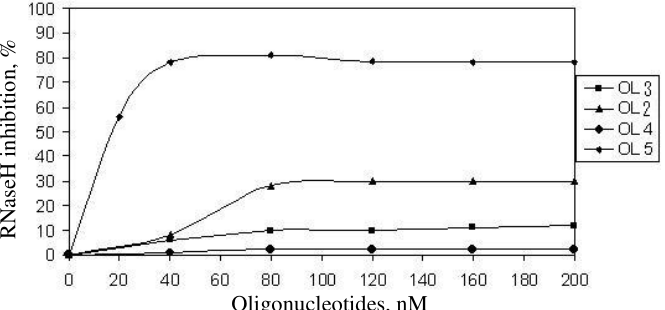
Figure 2. Inhibition of RNase H activity of MoMuLV RT by dumbbell